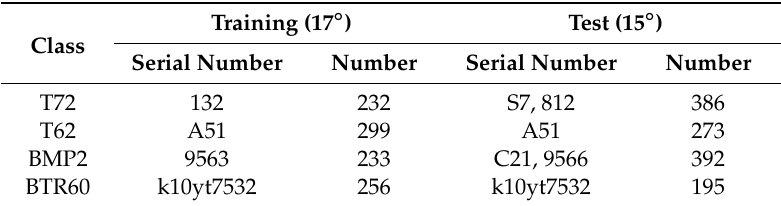
Figure 11. Illustration of target images in different configurations (titled by their serial numbers). All targets have an azimuth angle of 90° and a depression angle of 17°. Table 7. Dataset for the configuration test.